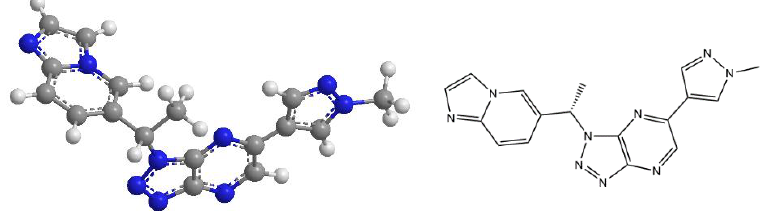
Figure 2. Chemical structure of Savolitinib.